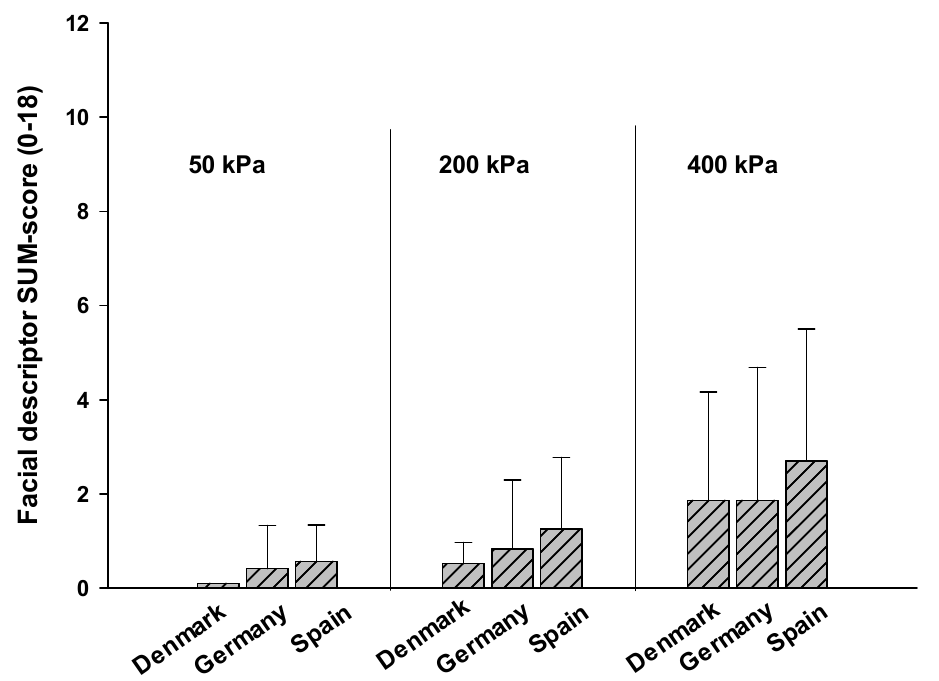
Figure 2. Step 3, encoding—comparison between countries: Comparing mean SUM-scores (SD) of individuals with dementia from different countries.